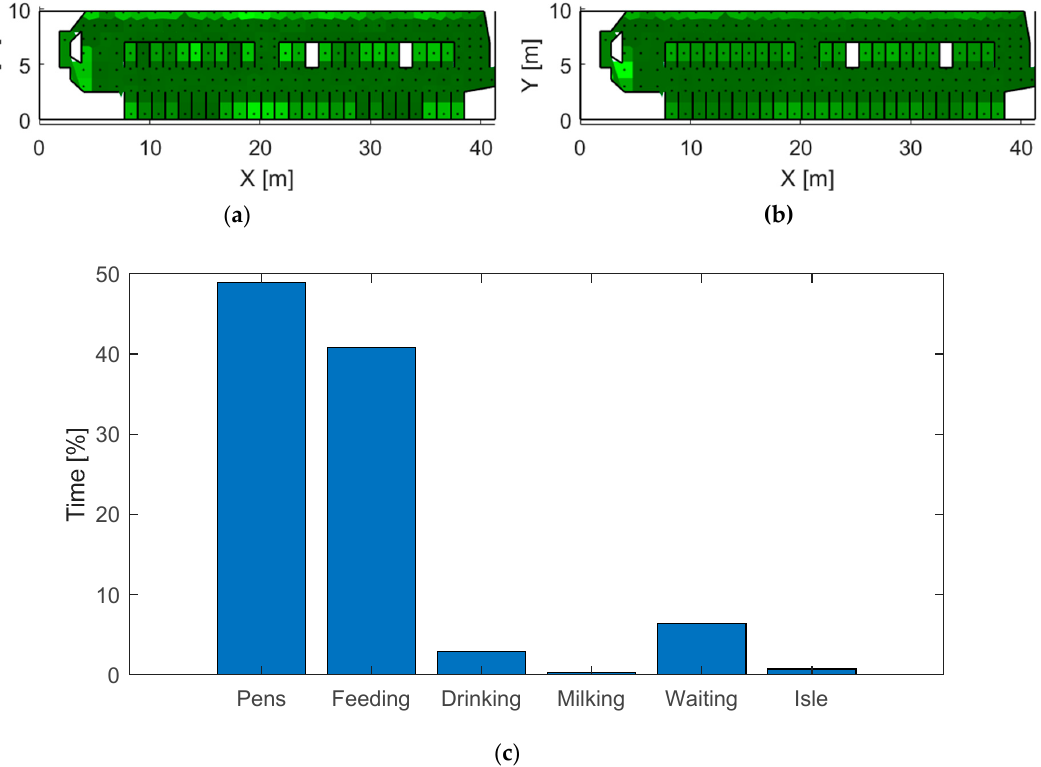
Figure 13. Relative frequencies of locating in the barn mapping points for one cow ( a ) and all cows ( b ) calculated by the localization system. The histogram shows the time distribution of the cow’s preferable locations ( c ).